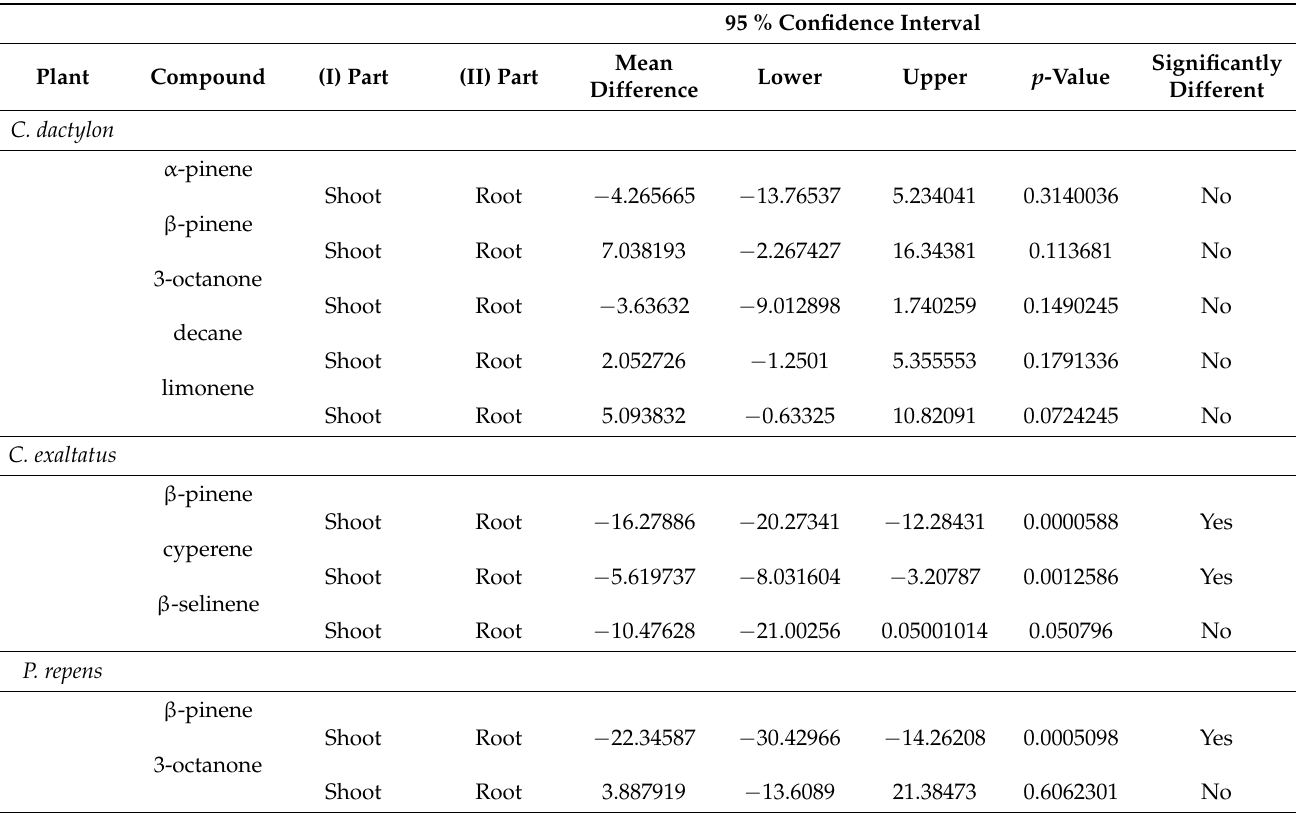
Table 3. Post-hoc Tukey analysis of six compounds found in the headspace samples of both the root and shoot samples of each of the three graminoid